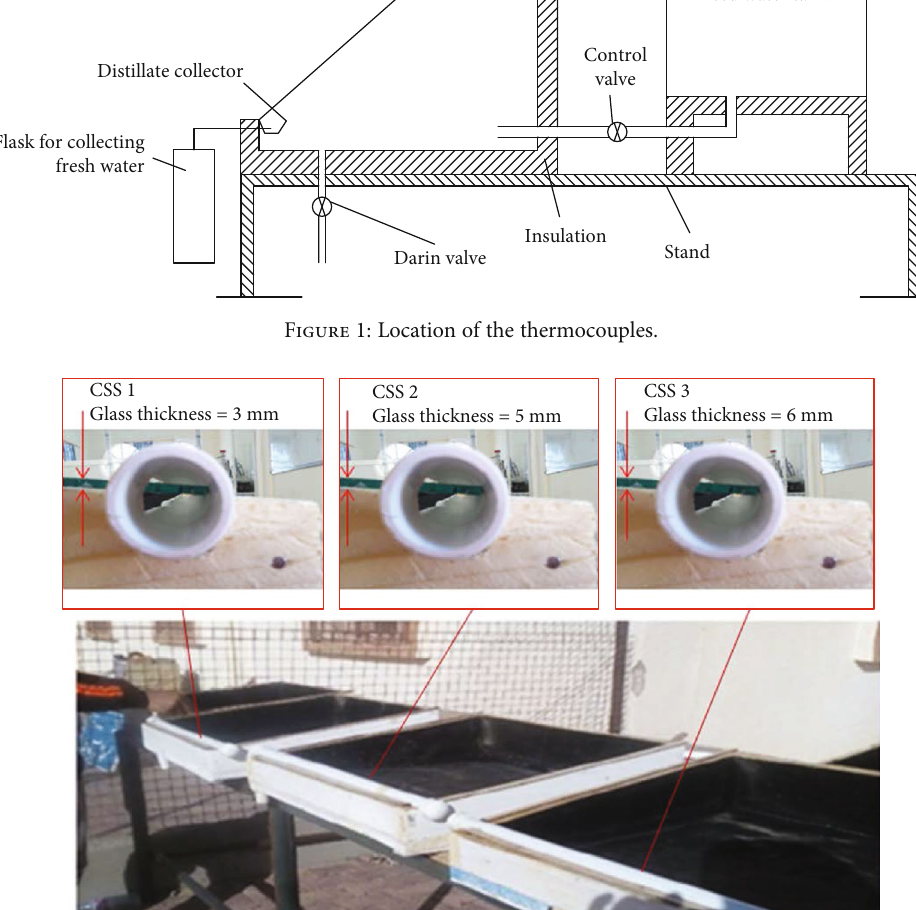
Figure 2: Photographic view of the experimental